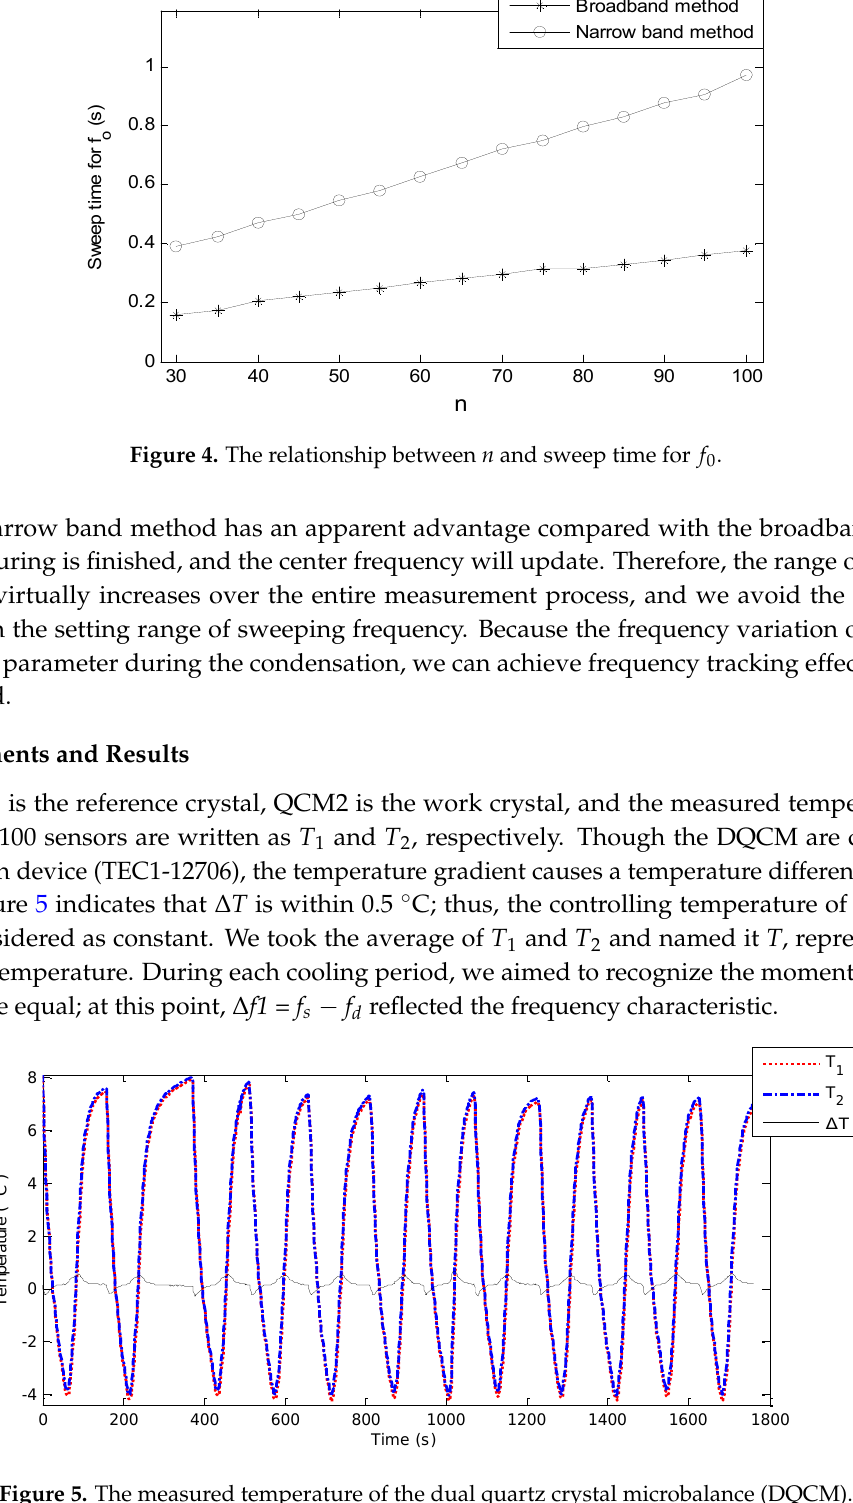
Figure 4. The relationship between n and sweep time for f 0 .